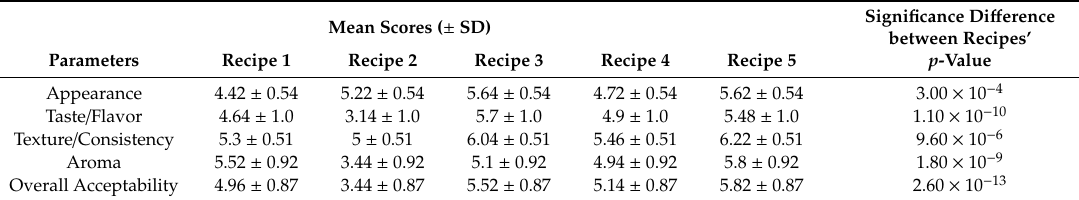
Table 8. Mean scores for sensory evaluation ratings.